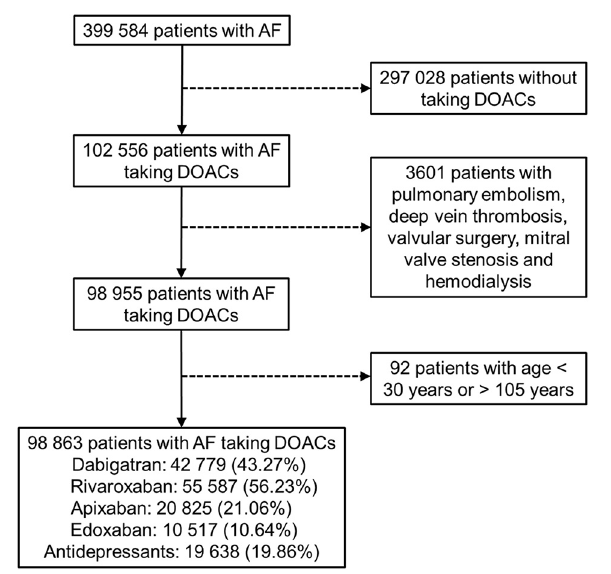
FIGURE 1 | Enrollment of patients with non-valvular atrial fibrillation (AF) using direct oral anticoagulants (DOACs).